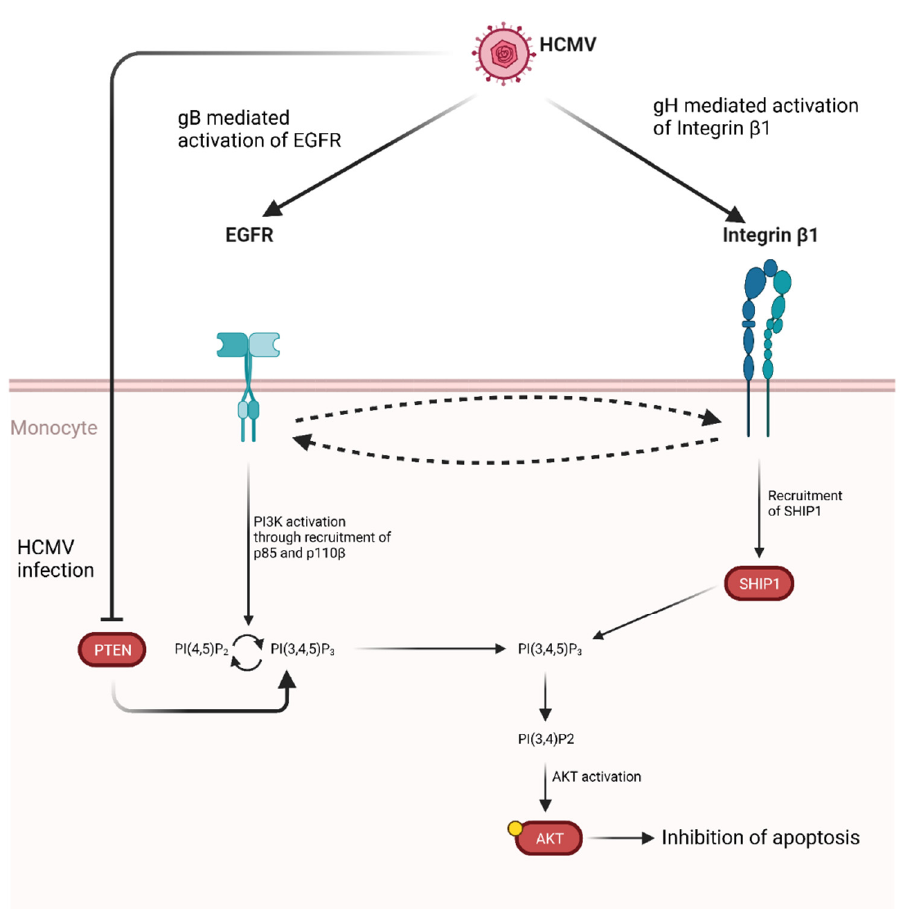
Figure 5. Proposed model for HCMV glycoprotein mediated AKT activation in monocytes. Following HCMV infection, gB and gH bind and activate EGFR and integrin β 1, respectively. Cross-activation between receptors has been shown. Activation of EGFR through gB binding leads to PI3K activation through the recruitment of p85 and p110 β . This, in turn, promotes the conversion of PI(4,5)P 2 to PI(3,4,5)P 3 . This process is normally regulated by PTEN, which catalyzes the opposite reaction, however HCMV infection also inhibits PTEN, thus shifting the balance in favor of PI(3,4,5)P 3 production [295]. At the same time gH binding to integrin β 1 leads to SHIP1 recruitment which converts PI(3,4,5)P 3 in PI(3,4)P 2 , thus activating AKT through a non-noncanonical pathway and ultimately up-regulating anti-apoptotic proteins. Credits: created with Biorender.com.